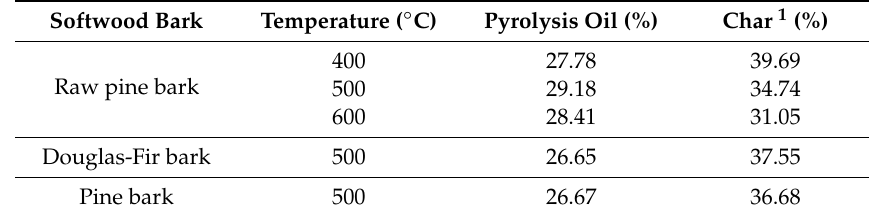
Table 1. Yields of pyrolysis oil and char from raw pine bark, pine, and Douglas-Fir bark.